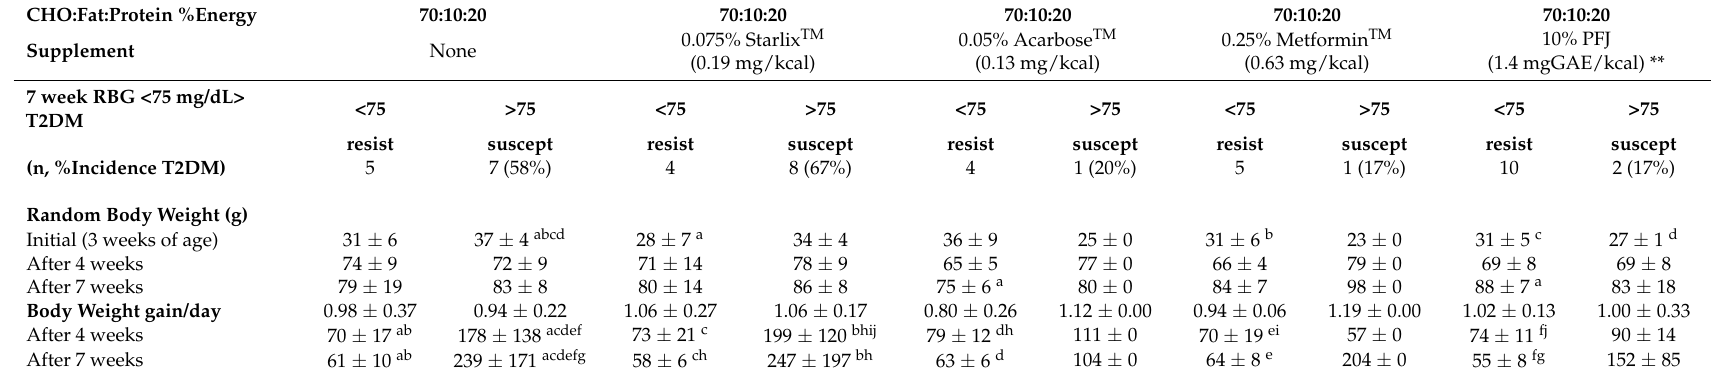
* Diet represents CHO:Fat:Protein %energy with Glycemic Load of 304/2000 kcal, 4.0 kcal/g. Values are mean ± SD; ** PFJ supplemented at 5.4 mgGAE/g diet; a, b Means in a row sharing common superscripts differ ( P < 0.05) by one-way ANOVA and Fisher’s PLSD test; Starlix TM (Nateglinide, Novartis); Acarbose TM (Bayer Pharmaceuticals); Metformin TM (Glucophage, Bristol-Myers